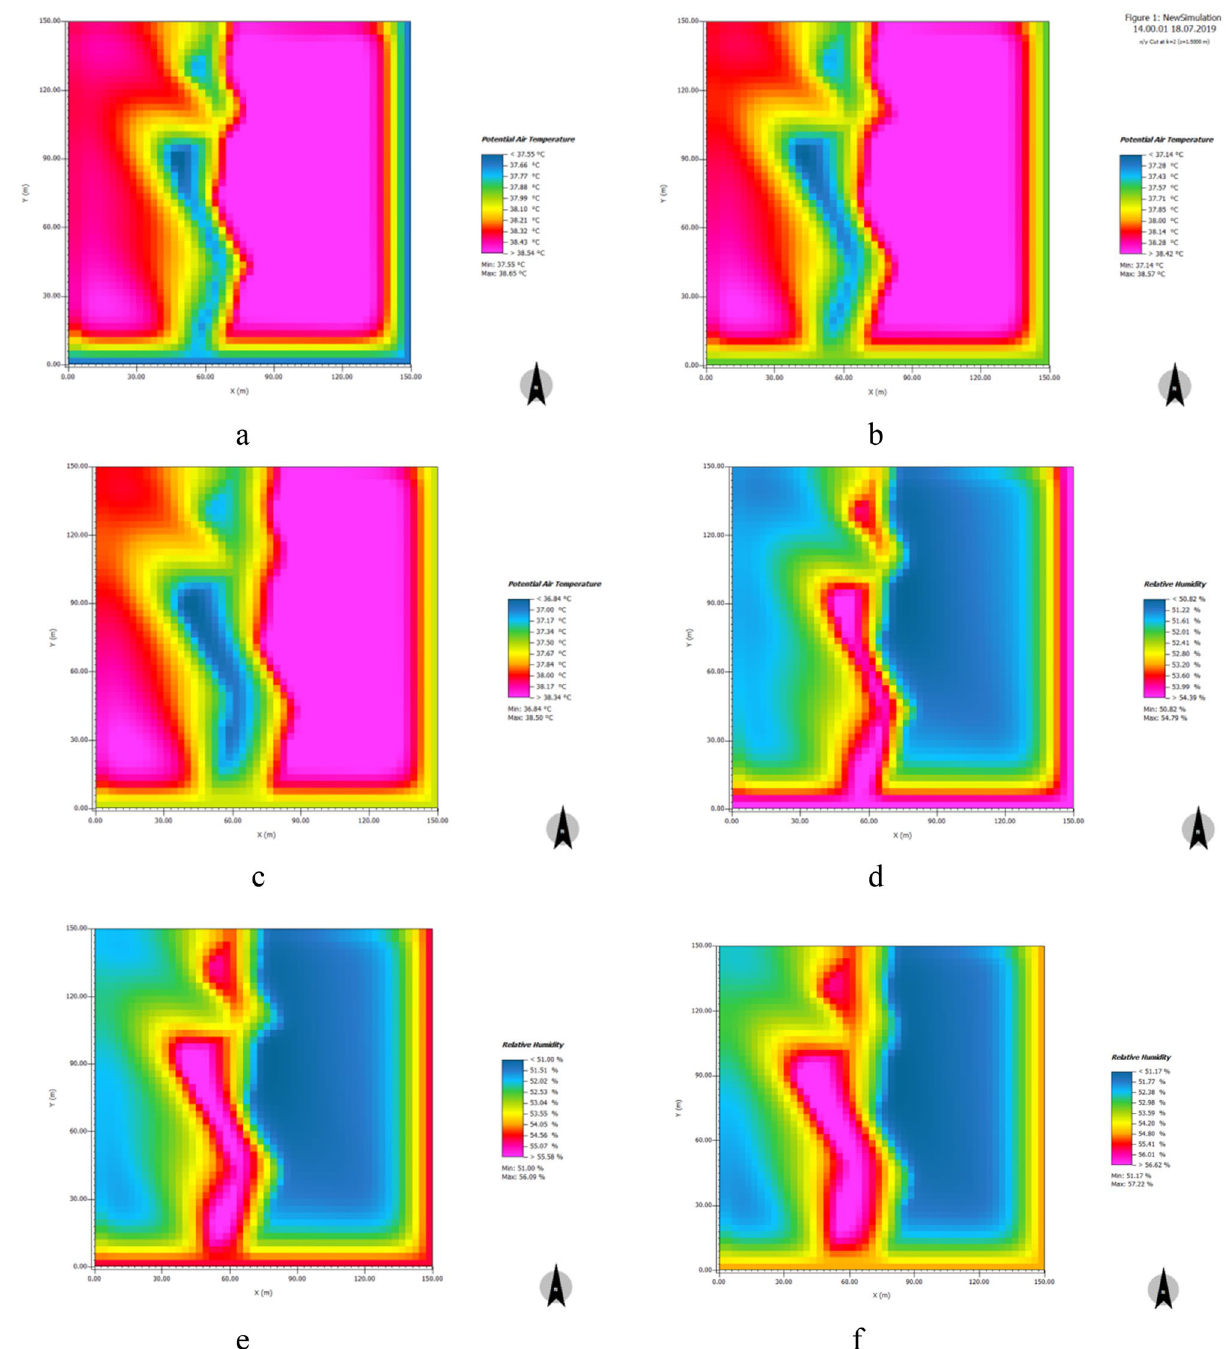
Figure 16. Distribution characteristics of cooling and humidifying effects of simulated increase of banded water area at 14:00. ( a ) original cooling effect of banded water in the sample area; ( b ) cooling effect of 5% increase in water area; ( c ) cooling effect of 10% increase in water area; ( d ) original humidifying effect of banded water in the sample area; ( e ) humidifying effect of 5% increase in water area; ( f ) humidifying effect of 10% increase of water